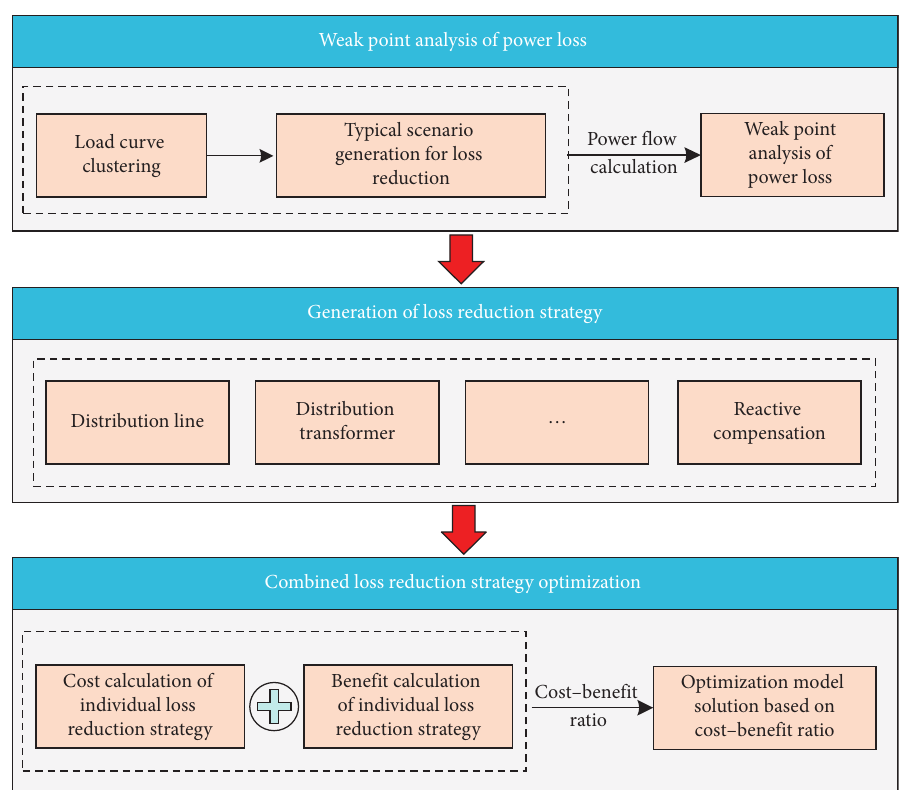
Figure 1: The proposed framework of combined loss reduction strategy